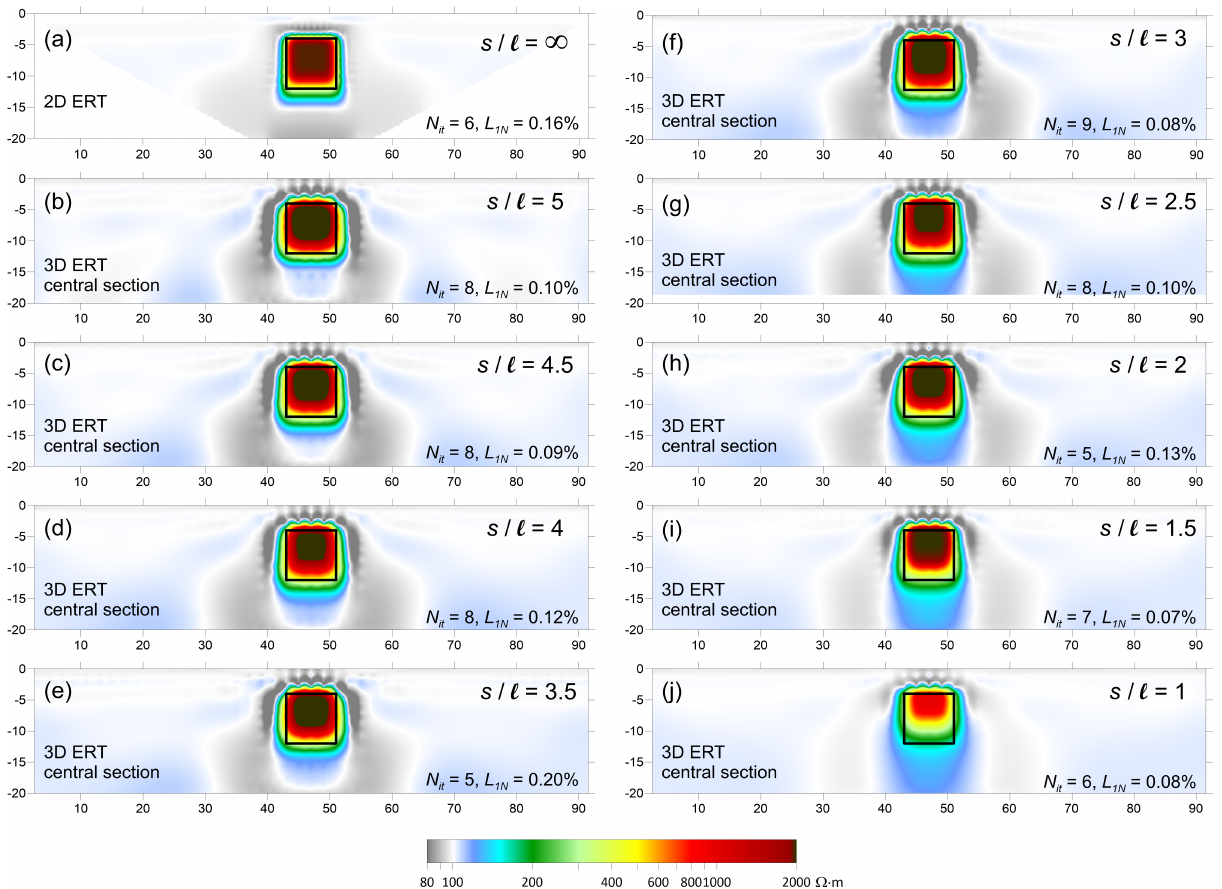
Figure 7. Central sections ( d = 0 ) extracted from 3D ERT inverse models obtained starting from the 3D models of prism-shaped resistive blocks. ( a ) s / l = ∞ (2D model) and ( b – j ) from s / l = 5 to s / l = 1 (cube model). The orthogonal distance d between the section and the projection on the surface of the center of the cube was equal to zero for all the sections. The solid black line indicates the boundaries of the